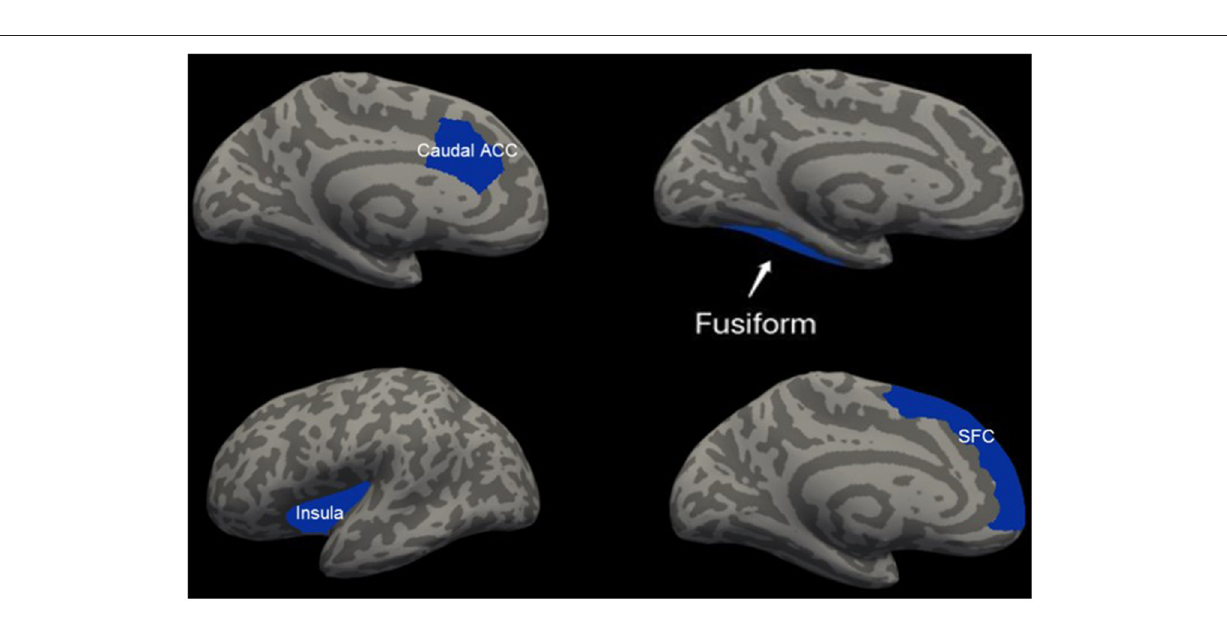
FIGURE 2 | Regions of significant increased cortical thickness (blue) in female participants, compared with male participants. Left column represents in patients with mTBI and right column represents in healthy controls. Regions in the caudal anterior cingulate cortex (caudal ACC), fusiform cortex and superior frontal cortex (SFC) in the left hemisphere were significant at P < 0.0125 after Bonferroni-correction. Region in the left insula cortex was not significant at P = 0.036 after